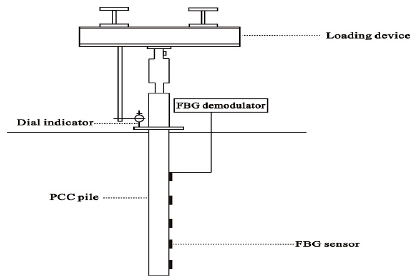
Figure 3. Static load model test.